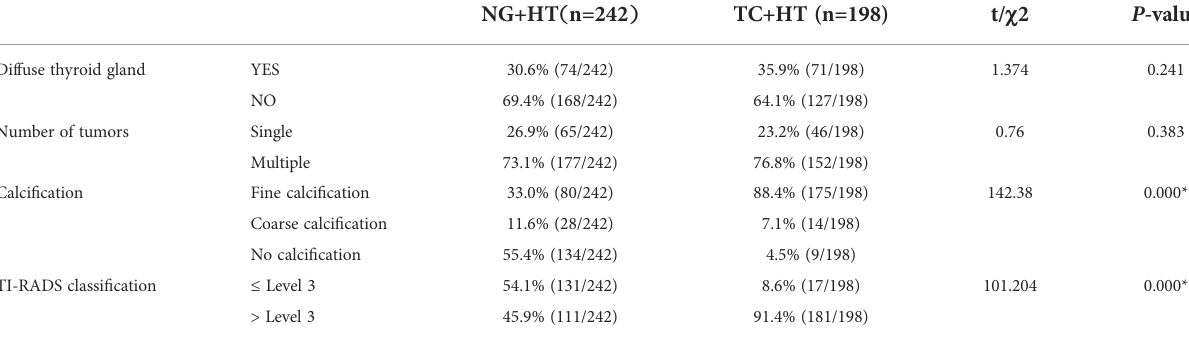
TABLE 2 Ultrasonography features of nodular goiter with HT and TC with